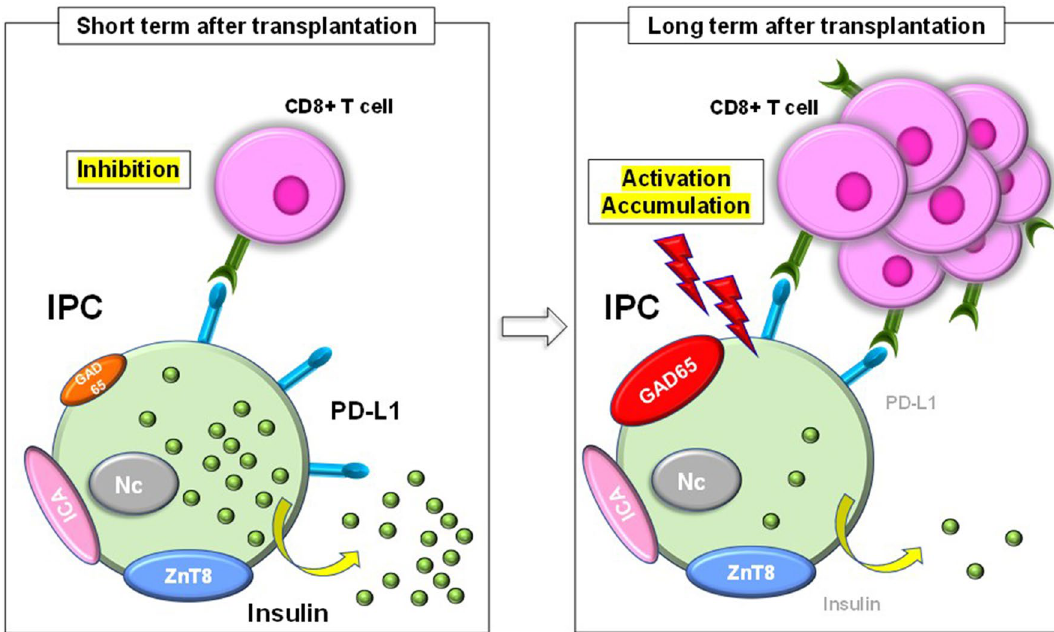
Figure 5. Proposed model for the autoimmune response to IPC transplantation in NOD mice with